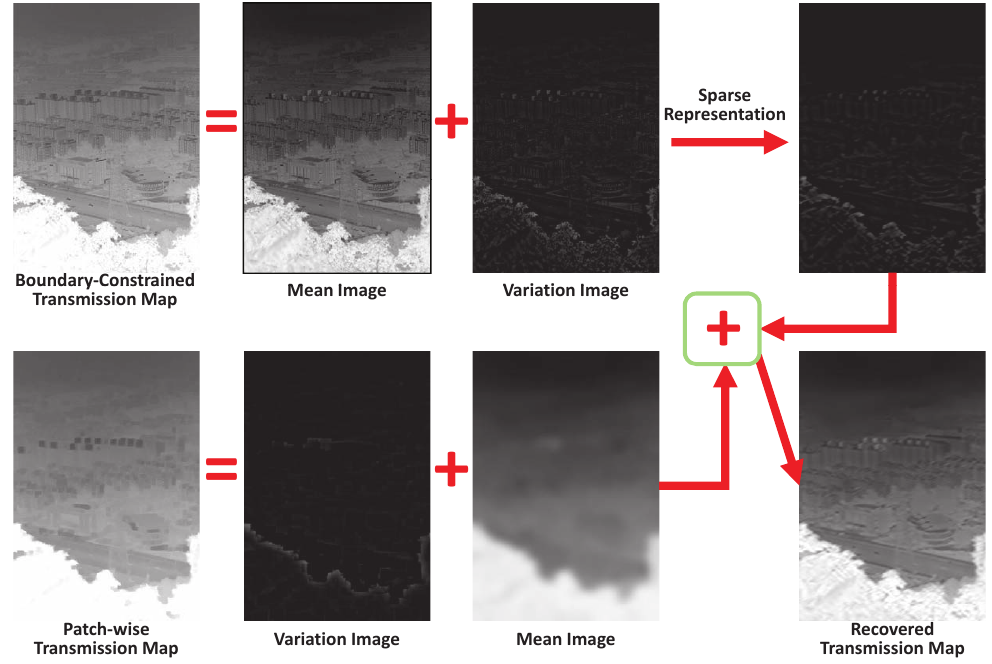
Figure 4. The framework for our proposed method recovering the transmission map using sparse